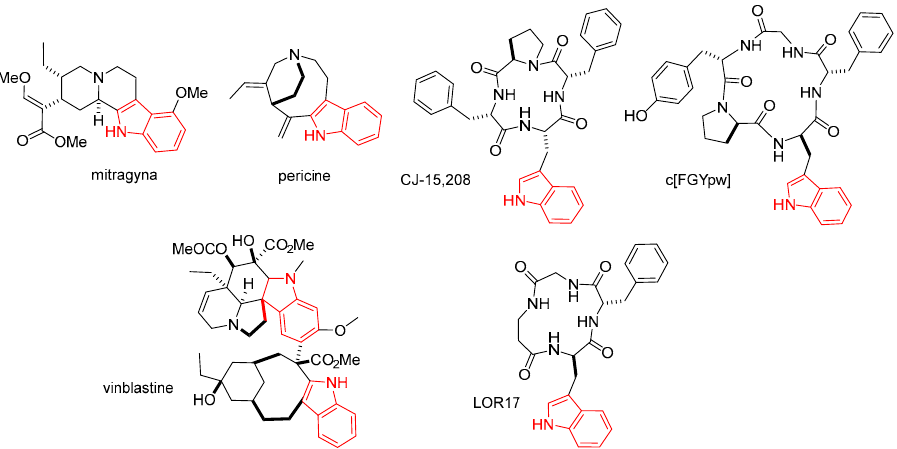
Figure 1. Structures of the indole alkaloid mitragyna, and pericine, vinblastine, and the cyclopeptides CJ-15,208, c[FGYpw], and c[FG- β -Ala-w] (LOR17); the indole nucleus is rendered in red.